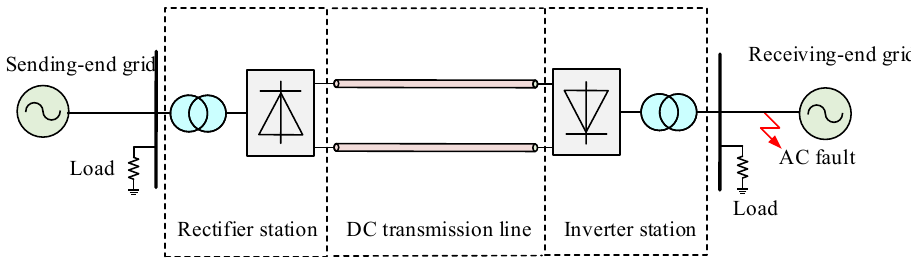
Figure 1. Topology of LCC-HVDC.